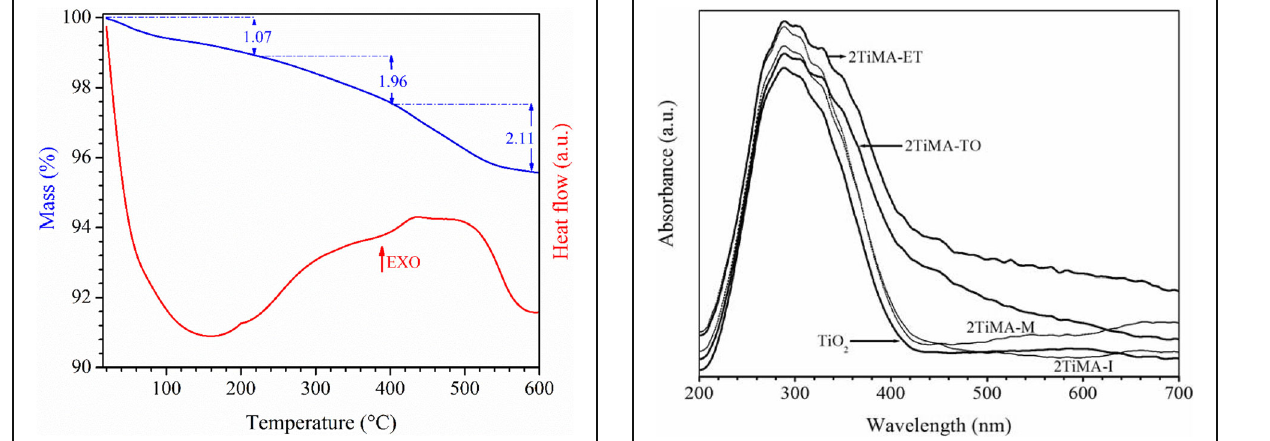
Fig. 8 UV-Vis diffuse reflectance spectra of the samples: pristine TiO 2 , 2TiMA-M, 2TiMA-I, 2TiMA-TO, and 2TiMA-ET